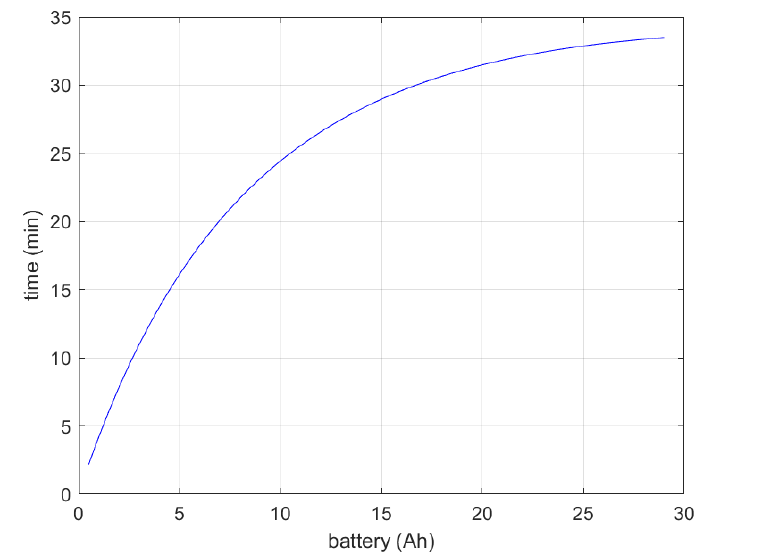
Figure 17. Electric-only flight time, excluding gas